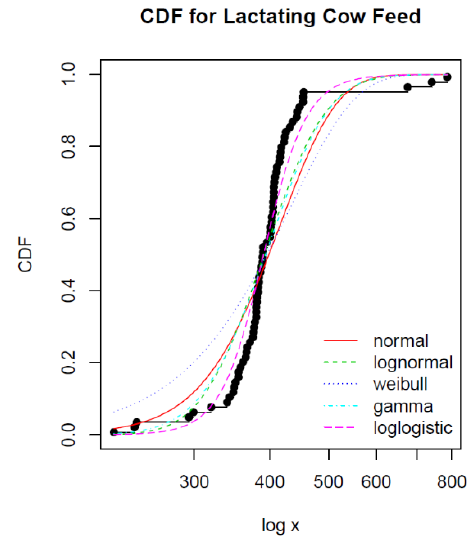
Figure 4. Cumulative distribution function (CDF) plots of the empirical distribution and fitted (theoretical) distributions against the input values of x for the lactating cow feed data.